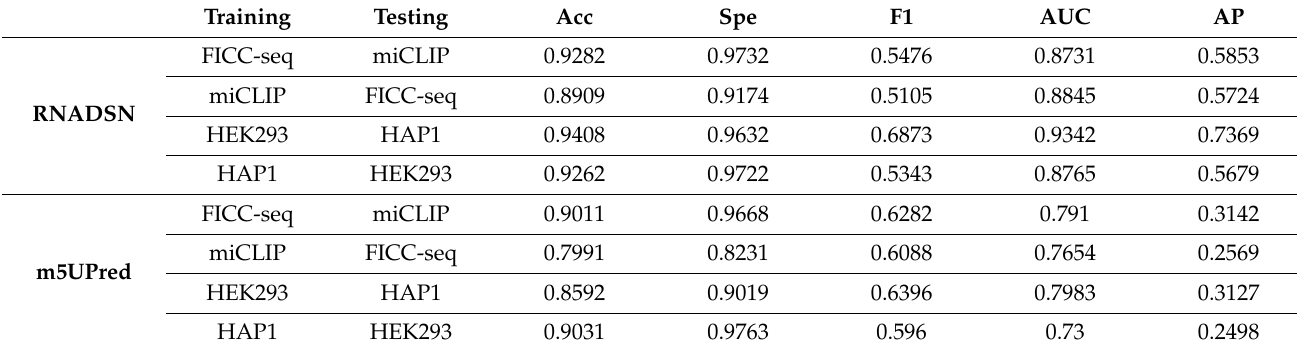
Table 3. Model performances using different training data.